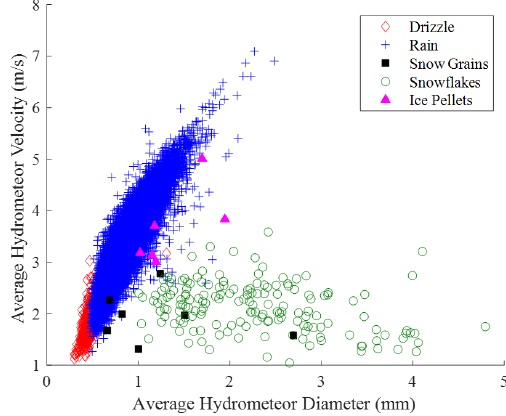
Figure 5. Relationship between size and velocity for the modal hy- drometeor at each